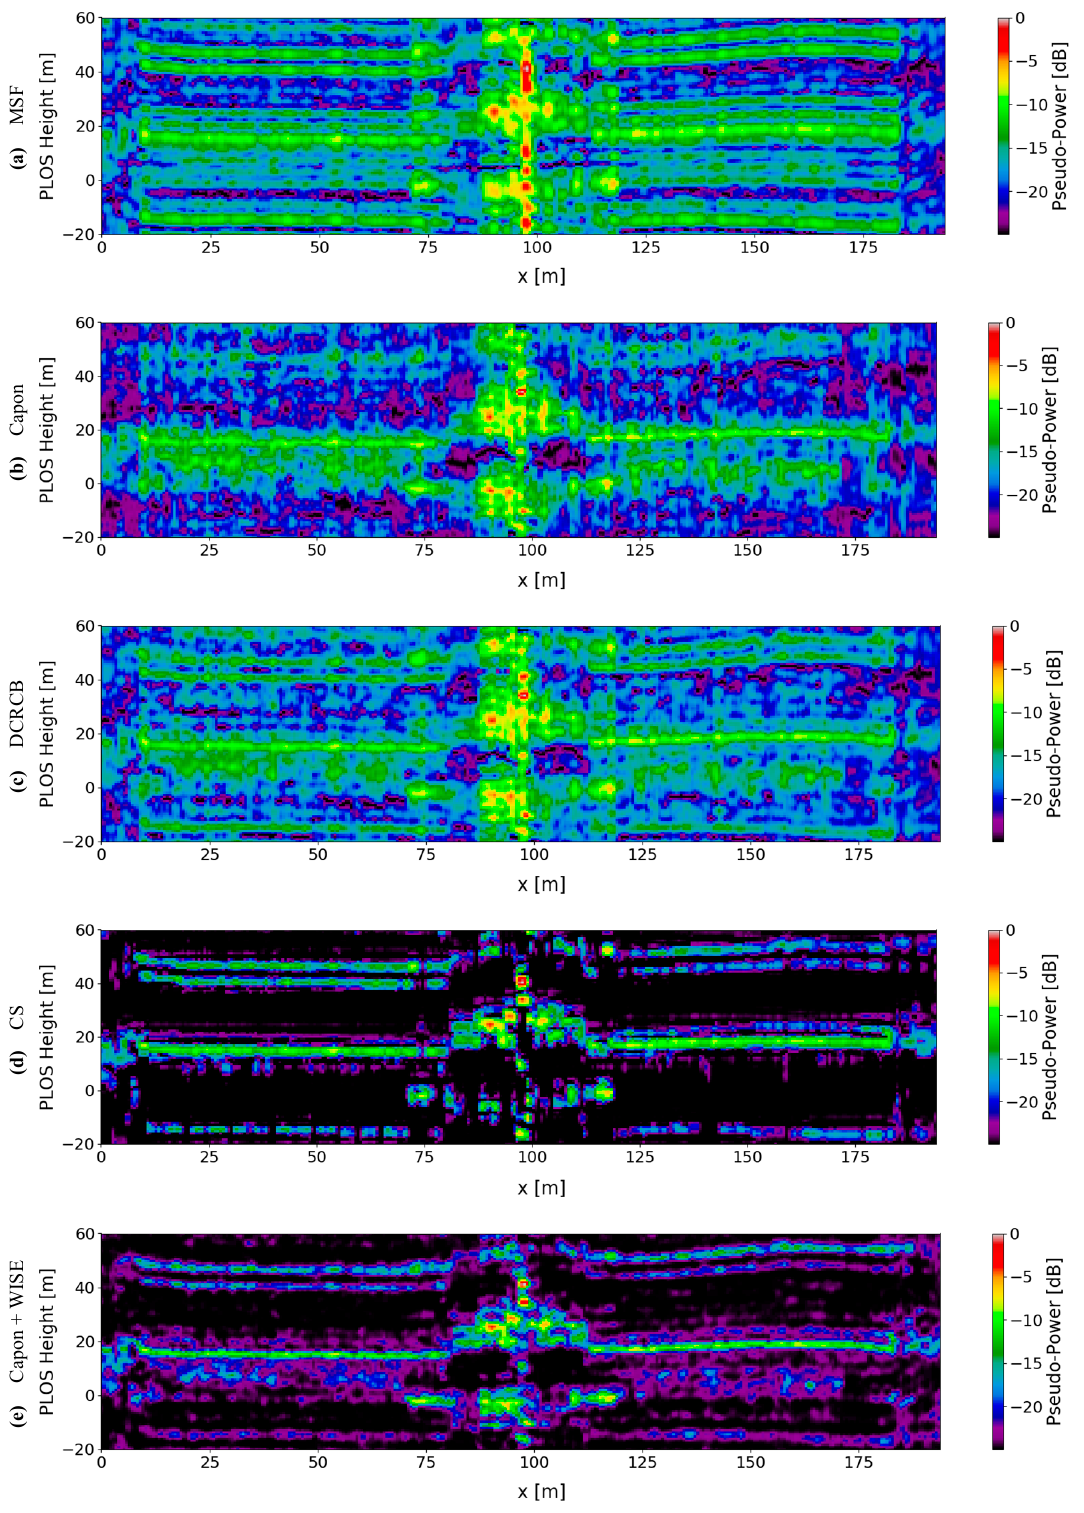
Figure 9. VV tomograms retrieved from the area depicted by the red line crossing the ROI specified in Figure 5. We perform focusing using ( a ) MSF, ( b ) Capon, ( c ) DCRCB, ( d ) CS and ( e ) Capon + WISE. A 15 × 3 (range/azimuth) pixel window is employed to perform multilooking via Boxcar filtering. All tomograms are normalized with respect to the (pseudo) power recovered by MSF.